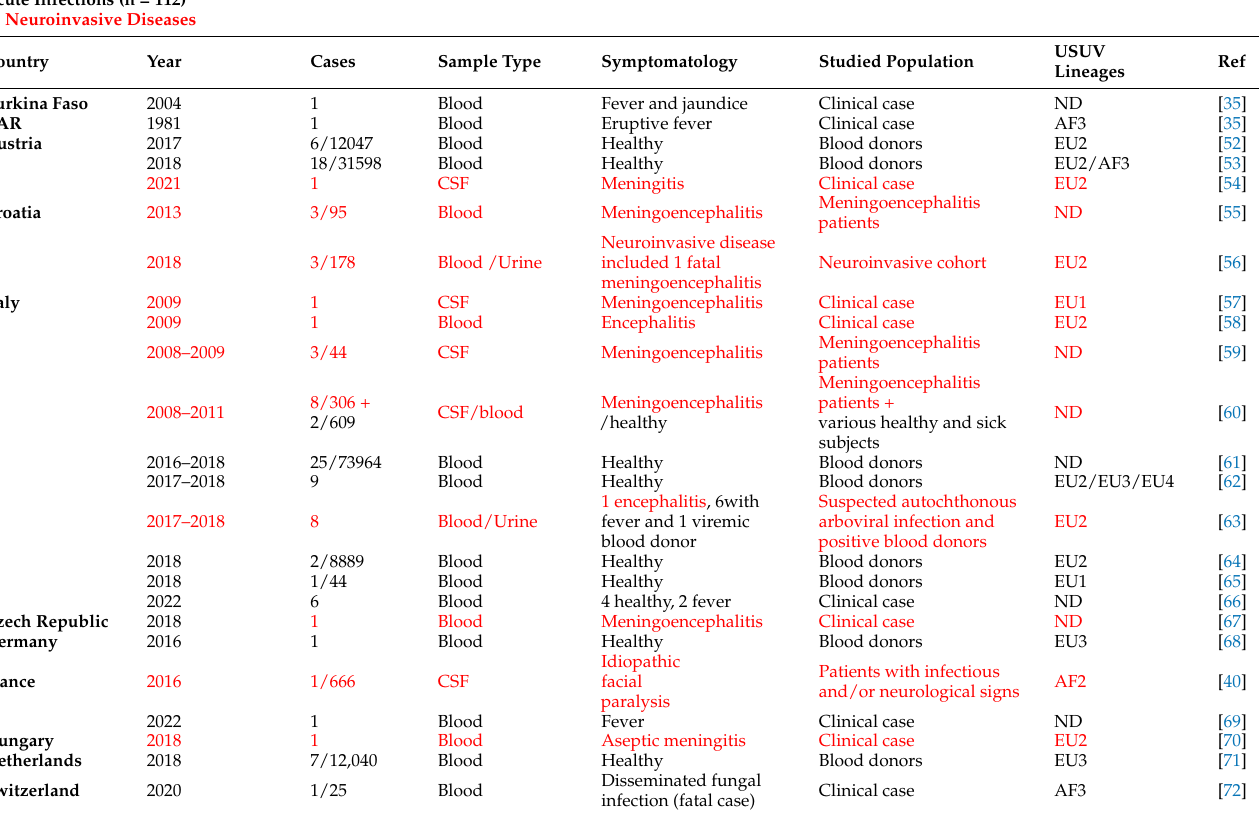
Table 1. Description of human Usutu cases worldwide and associated viral lineages. In red: human USUV cases associated with neurological